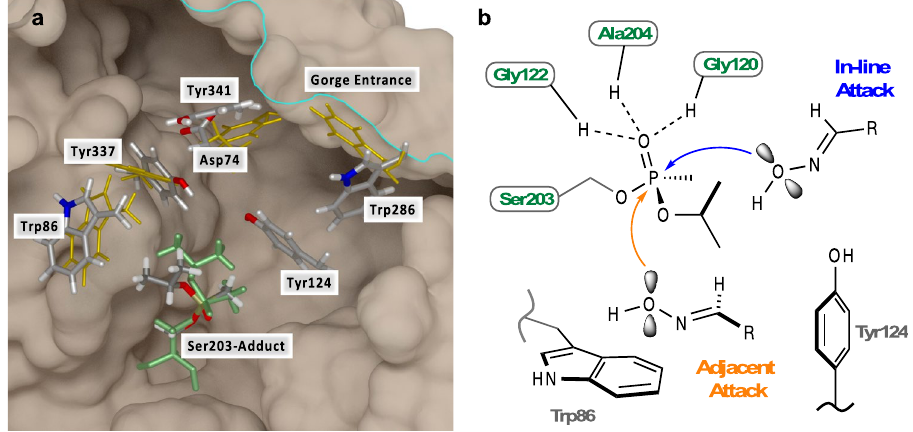
Figure 2. ( a ) Five AChE protein structures used in the docking/rescoring calculations are aligned by key active site residues, [Human Xtal (5FPQ), Human Model (derived from 1B41), Mouse 2Y2V, Mouse 2WHP, and Mouse 5FPP]. The sidechains of several residues that mediate binding of oximes have significant spatial variability. Alternate conformations are shown in gold; Asp74, Trp86, Trp286, Trp337, and Trp341. The isopropyl tail (green) of the adduct is rotated by ~ 50° around the isopropyl-O–P bond, placing the methyl groups closer to the Trp86 sidechain. Reactivator design needs to account for the active site plasticity to prevent unproductive binding. Figure created with VMD 60 . ( b ) Key AChE active site residues with two putative nucleophilic reaction mechanisms. The in-line attack mechanism places the approaching oxime group at 180° to the Ser203 oxygen atom in the Ser-O–P=O plane. The serine residue then becomes the leaving group, and the phosphate-oxime complex can leave the active site or recombine. In the adjacent attack scenario, there are two possible leaving groups, Ser203 and the isopropyl group. If the isopropyl group leaves then the enzyme is not reactivatable. A close interaction of the isopropyl group with the indole sidechain of Trp86 will fill the space available for binding and reduces the possibility of adjacent attack as seen in the 5FPP crystal